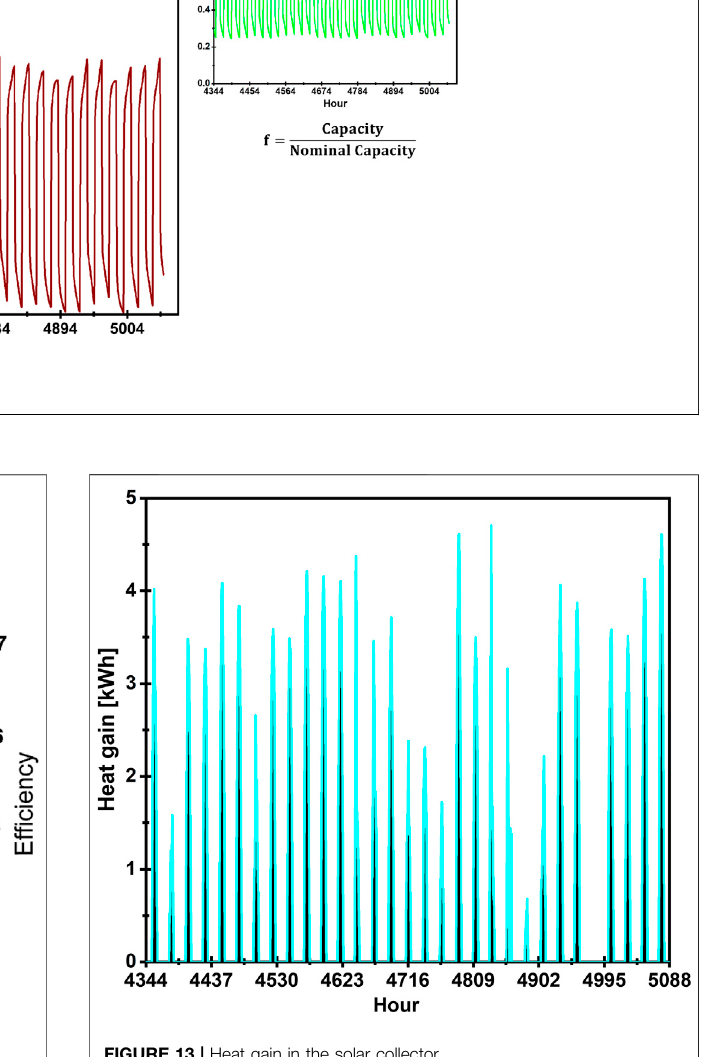
FIGURE 13 | Heat gain in the solar